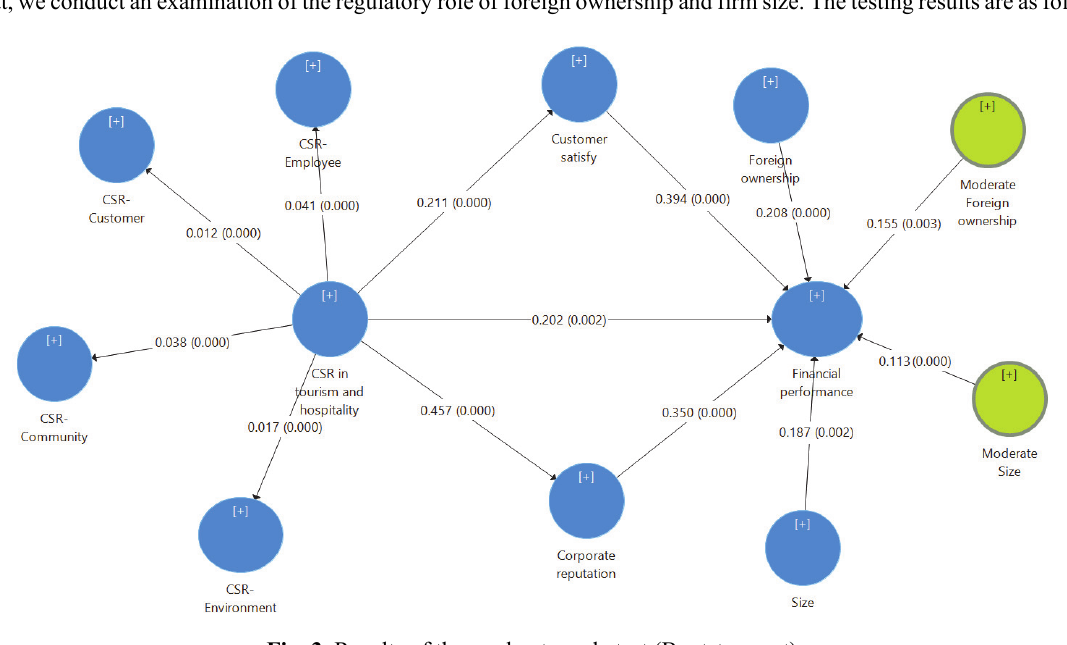
Original Sample Sample Standard Deviation (O) Mean (M) (STDEV)